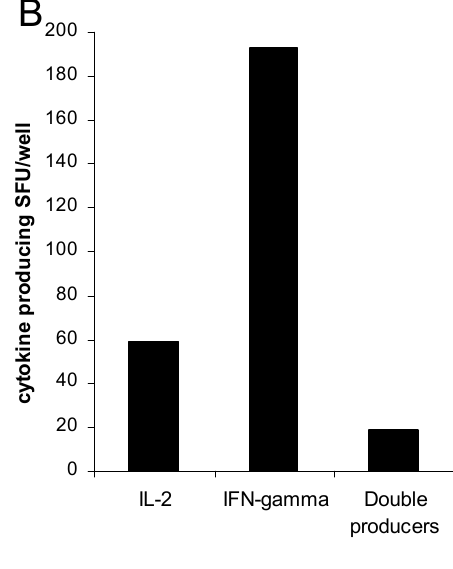
Figure 2. Functional heterogeneity of antigen specific immunity at the single cell level indicates IFN- γ producing memory cells usually do not produce IL-2. PBMC from a representative subject were challenged with mumps-antigen (1/80 dilution) in 20 h culture. 2-color ELISPOT assay was performed. Digital image of a representative well is shown in panel A . Blue spots represent IFN-  producing cells while red spots represent IL-2 producing cells. Spot forming units are represented in bar graph format in panel B